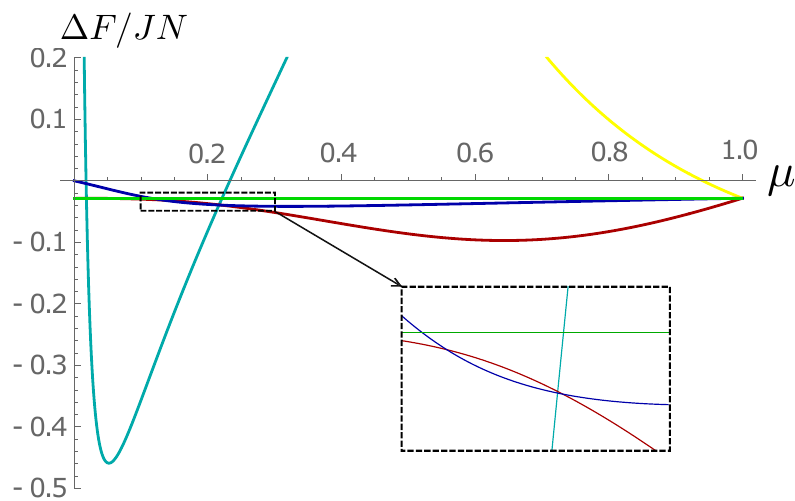
Figure 10 . The plot of the replica dependent part of the free energy on numeric solutions. Green line is the free energy on complex replica symmetric solution. All colors here correspond to the colors in the figure